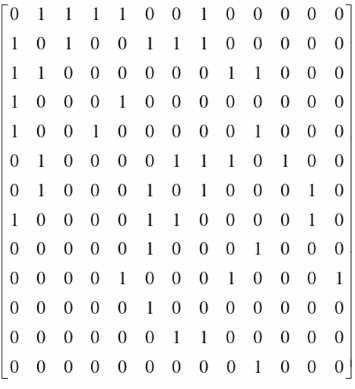
Figure 3. Conflict interference